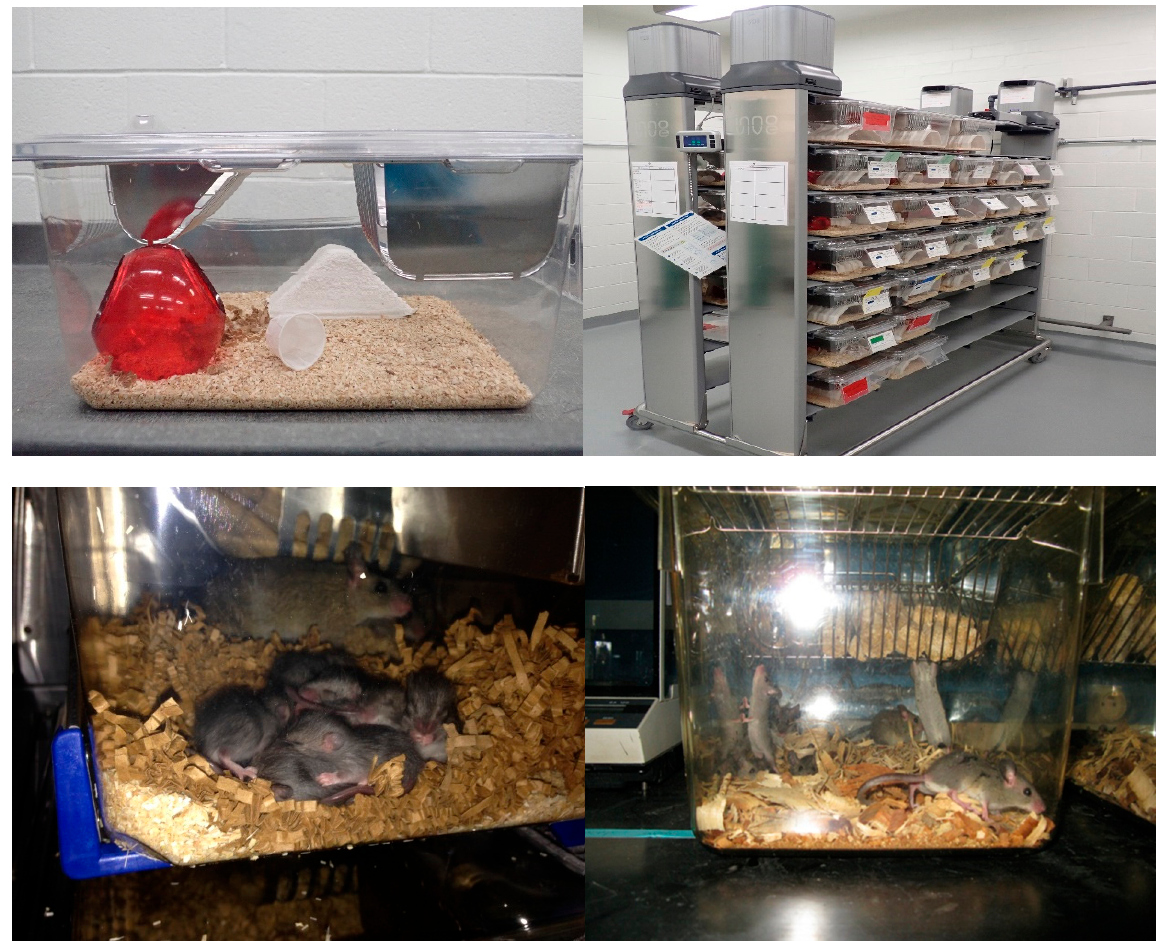
Figure 3. Caging setup for the Mastomys natalensis colony. Upper left: standard disposable caging unit with “locking” wire top, bedding, and enrichment. Upper right: ventilated rack dedicated to the Mastomys natalensis colony. Bottom left: dam and pups in a ventilated cage. Bottom right: sub adult Mastomys natalensis in a static caging unit in Mali just prior to shipment to Rocky Mountain Laboratories (RML).